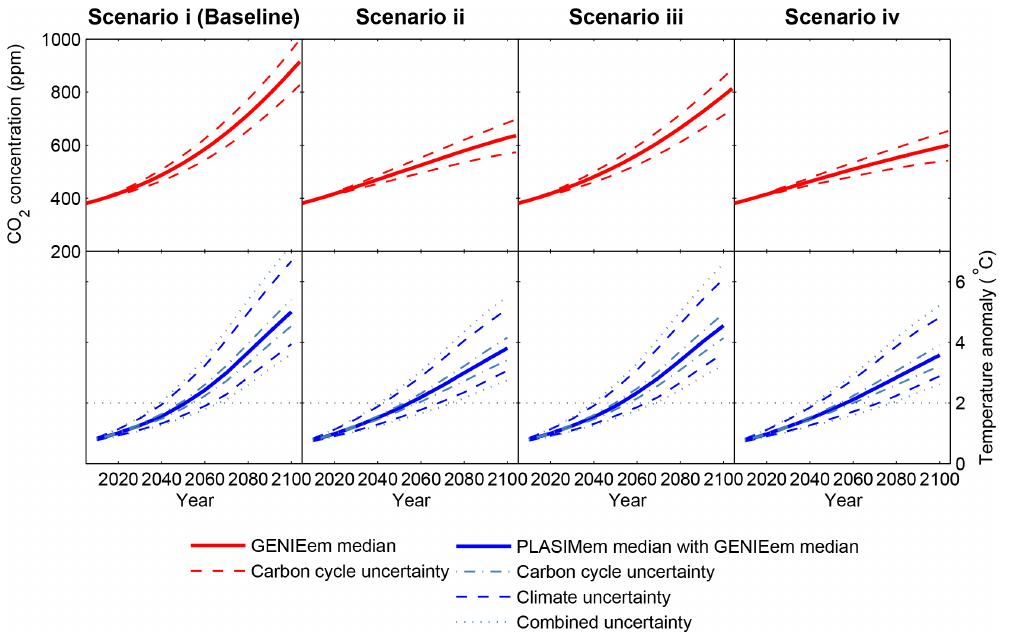
Figure 4. Top panels: median CO 2 concentrations for scenarios i (baseline), ii, iii and iv, simulated by GENIEem, with uncertainty bounds (GENIEem 5th/95th percentile). Bottom panels: median temperature anomalies relative to preindustrial conditions for scenarios a (baseline), d, i and j, simulated by PLASIM-ENTSem using median GENIEem CO 2 concentrations. Uncertainty bounds are based on carbon cycle uncertainty (PLASIMem median with GENIEem 5th/95th percentile), climate uncertainty (PLASIMem 5th/95th percentile with GENIEem median), and combined uncertainty (PLASIMem 5th/95th percentile with GENIEem 5th/95th percentile). The 2 ◦ C target, described as “the maximum allowable warming to avoid dangerous anthropogenic interference in the climate” (e.g Randalls, 2010), is also illustrated by the grey dashed